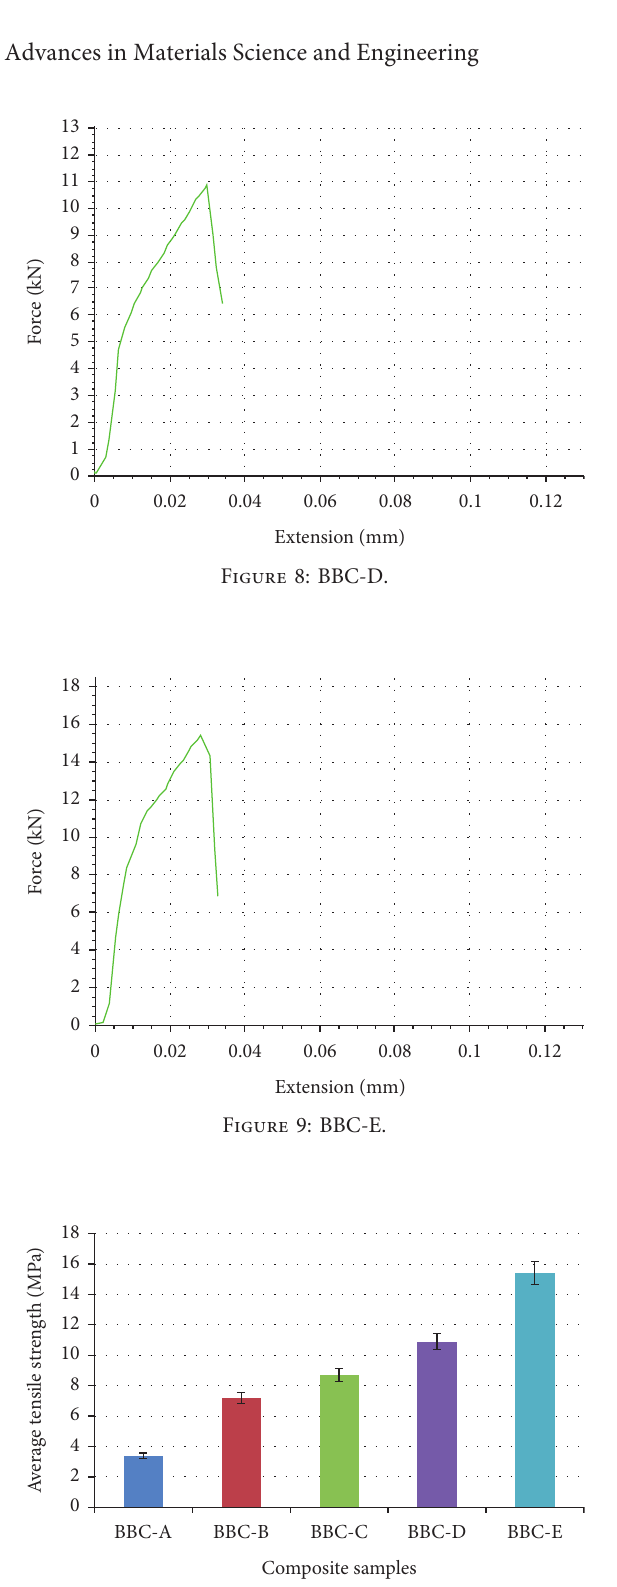
Figure 10: Tensile strength of composite samples.